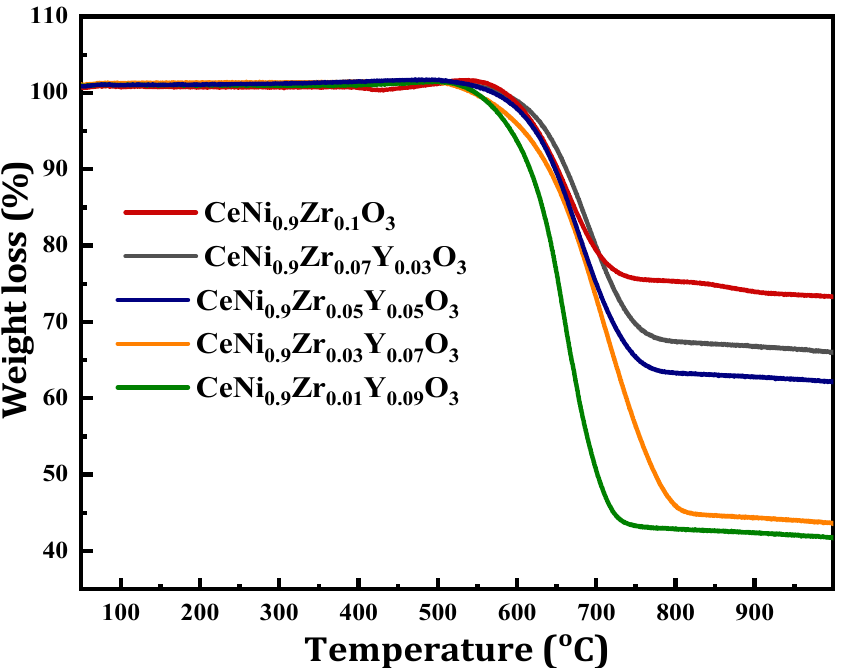
Figure 10. TGA Curves of perovskite catalysts CeNi 0.9 Zr 0 . 1 − x Y x O 3 (x = 0, 0.03, 0.05, 0.07, and 0.09) at 800 °C.